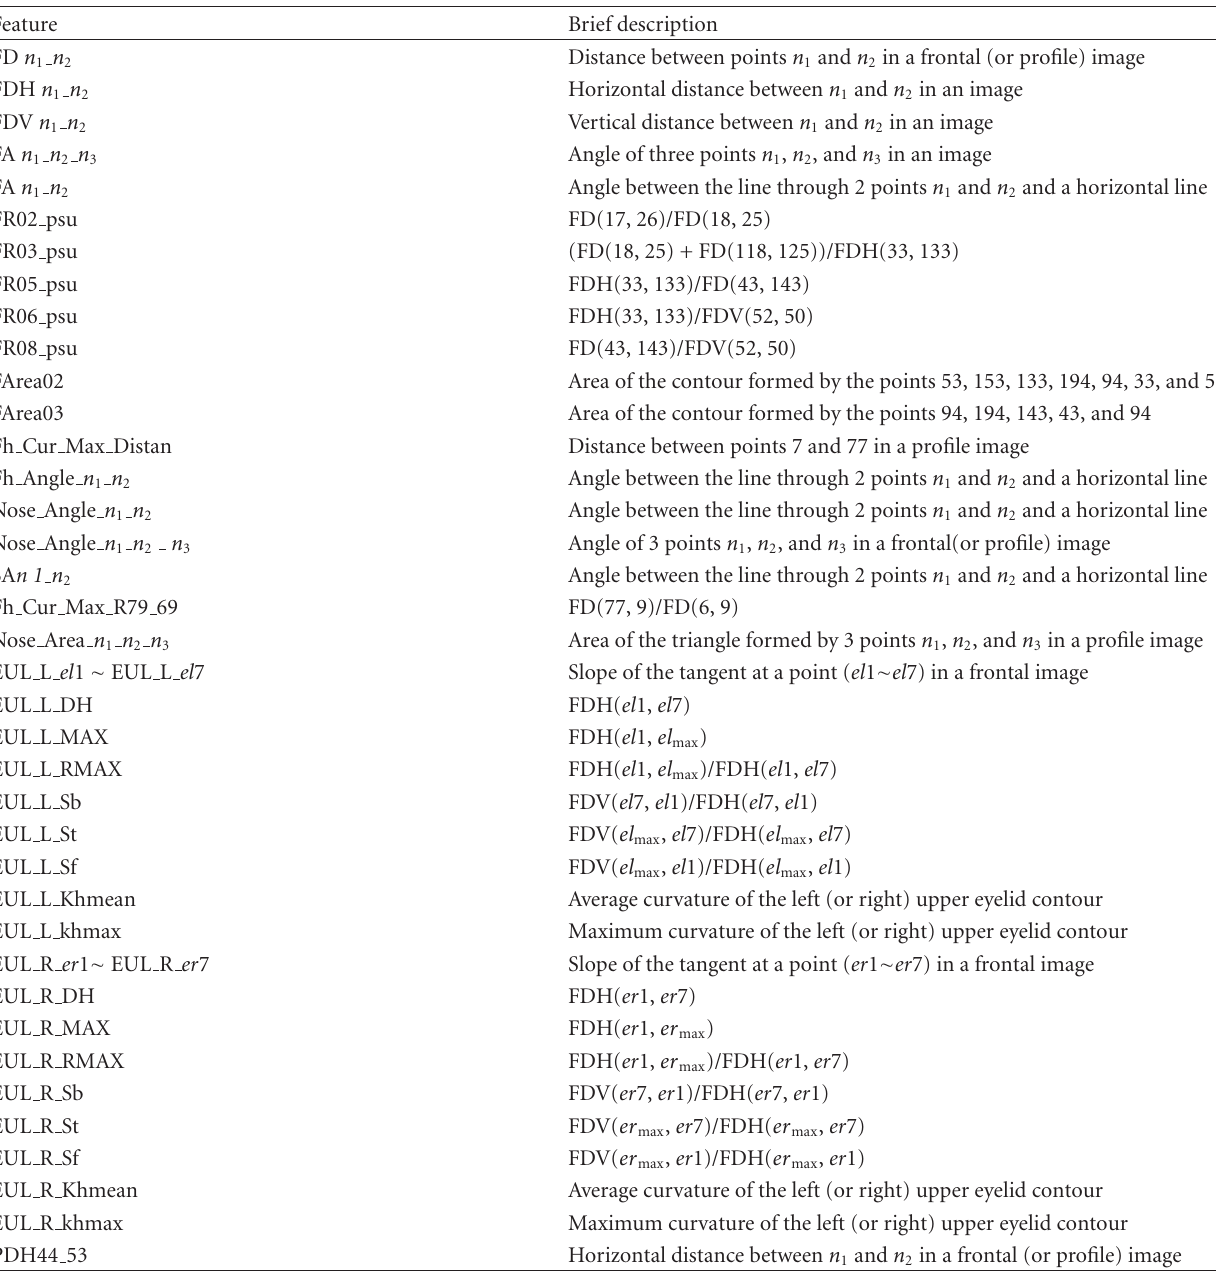
Table 1: All features used in this study and brief